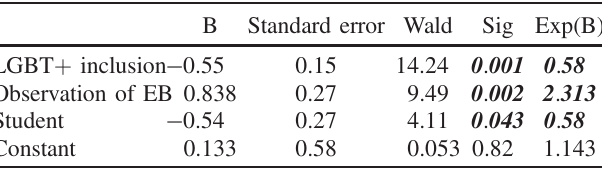
TABLE IV. Model 1: Climate model for consideration to leave a . TABLE V. Model II: Climate model for being out a B Standard error Wald